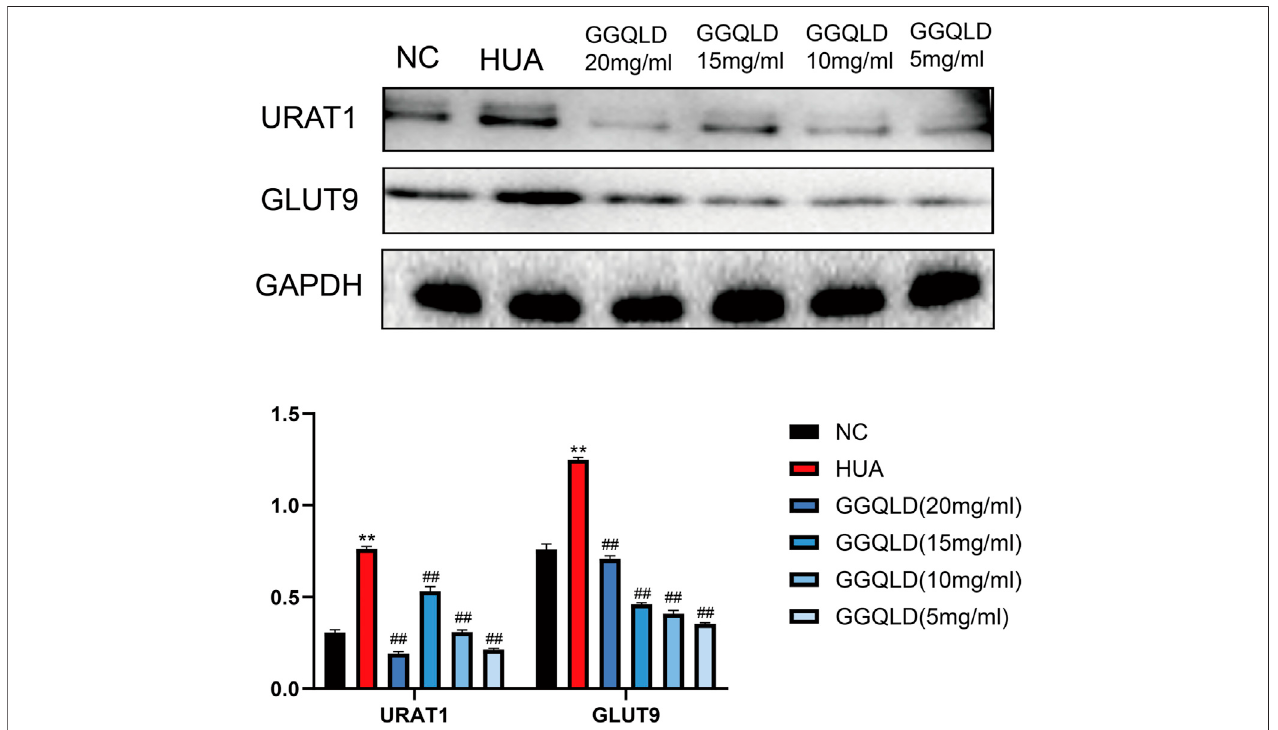
FIGURE 7 | GGQLD alleviated urate transporter expression in UA-stimulated PTECs. GGQLD signi fi cantly reduced URAT1 and GLUT9 expressions. n (cid:2) 3 independent experiments per group. * p ＜ 0.05 vs. NC, ** p < 0.01 vs. NC, # p < 0.05 vs. HUA, ## p < 0.01 vs.